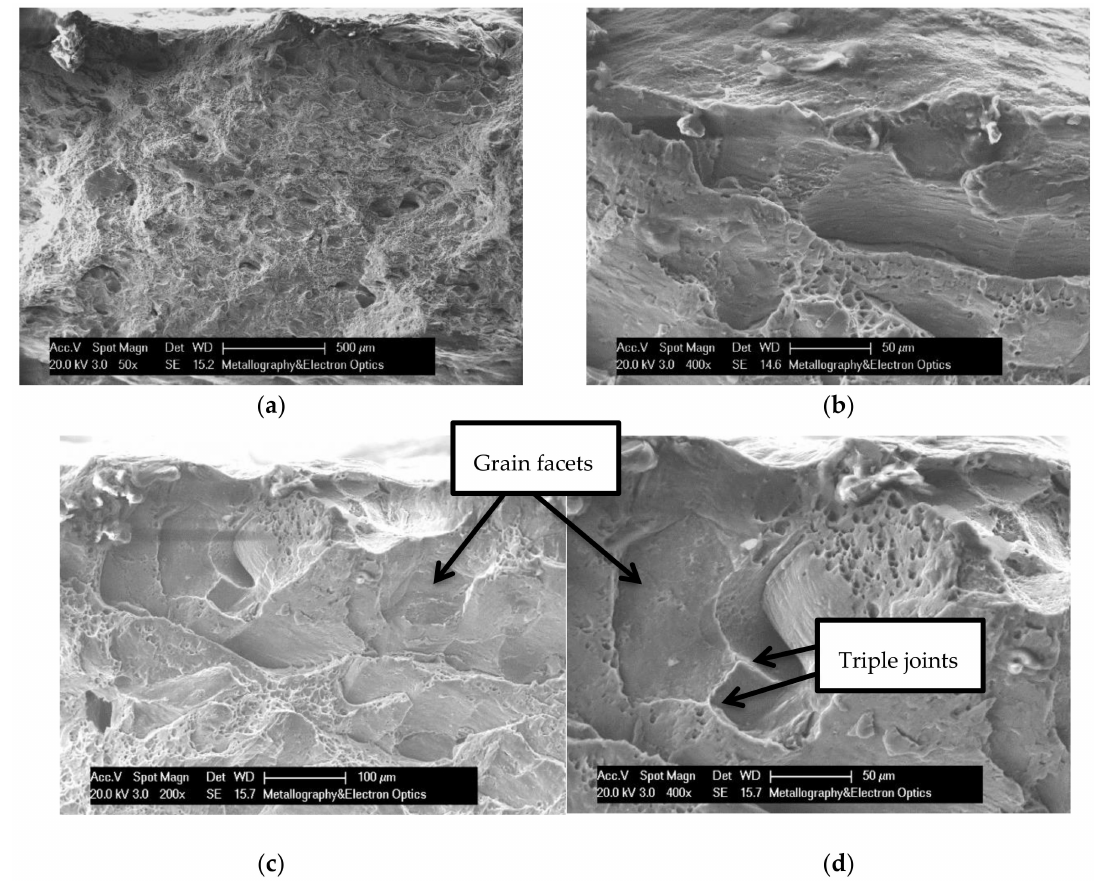
Figure 6. ( a – d ) SEM fractographs, fracture surface of tensile specimen with 2.9 mm thickness. Mixed fracture mode consisting mainly of intergranular fracture and lower percentage exhibiting dimpled morphology. Grain facets and triple joints are